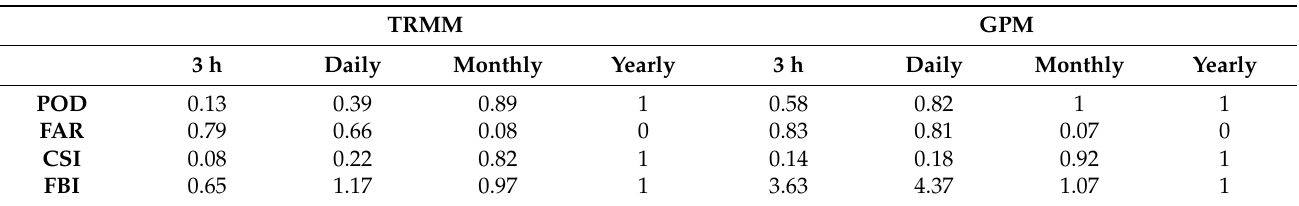
Table 3. Contingency statistical metrics results of 3B42 V7 and IMERG V5 precipitation estimates at multiple time scales from 2014 to 2017.